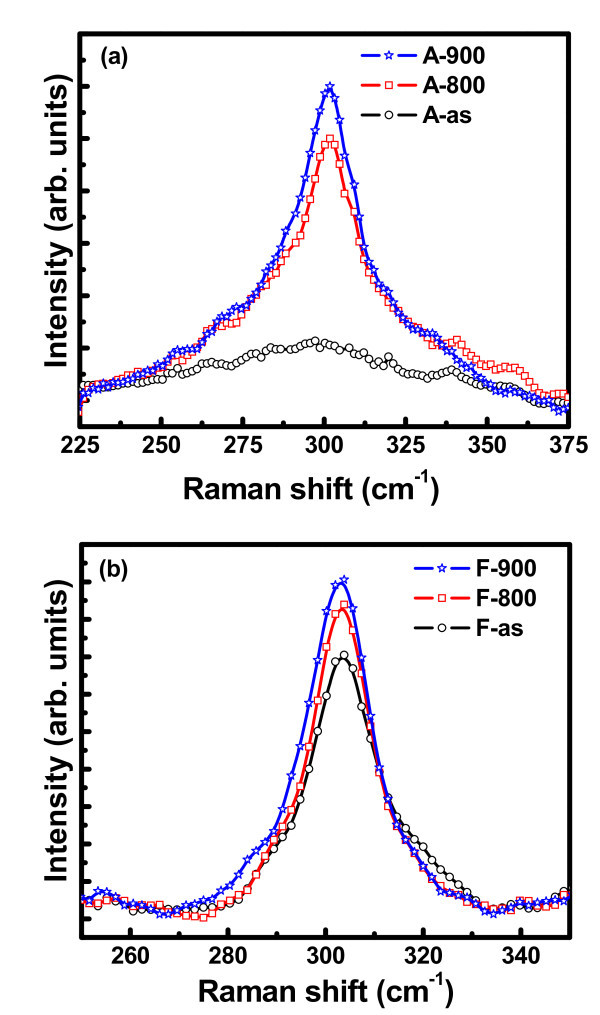
Raman spectra of Ge nanocrystals embedded in (a) Al2O3 and (b) HfO2 matrix in the as-grown and annealed state.